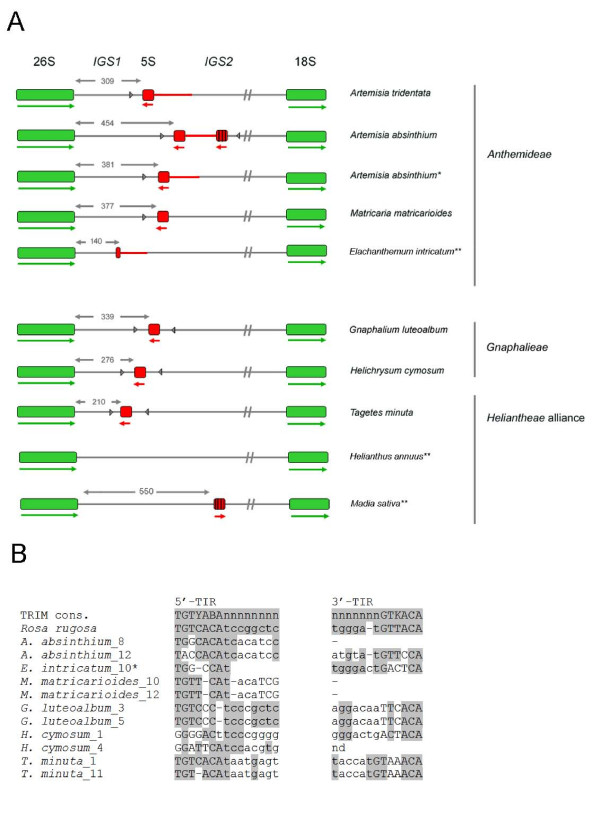
The position and organisation of 5S insertions within the 26S-18S intergenic spacer. (A). The 26S, 18S and 5S genic regions are in green and red boxes, respectively. Mutated or incomplete 5S copies are indicated by vertical strips. The sizes of IGS1 are depicted with thin lines above the units. Direction of transcription is illustrated by thick arrows below the genes. Arrowheads indicate sequences homologous to terminal inverted repeats (TIR) of Cassandra elements, aligned in (B). (*) the IGS type with a single 5S gene is the most abundant in A. absinthium; (**) species with typical unlinked arrangement of units.